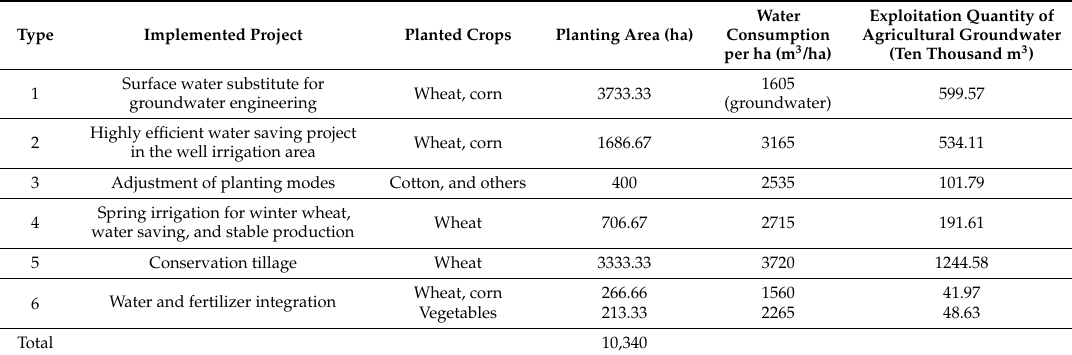
Table 1. Actual quantity of agricultural groundwater exploitation in Cheng’an County in 2015 (in the project areas).